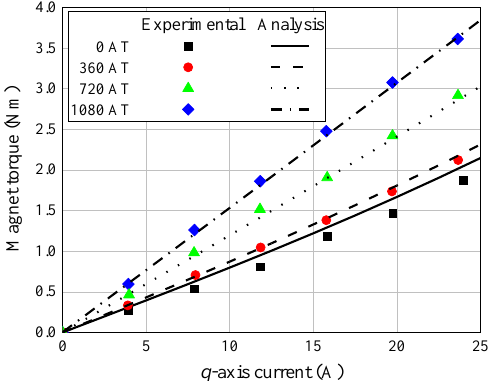
Figure 27. Experimental results of I–T characteristic.